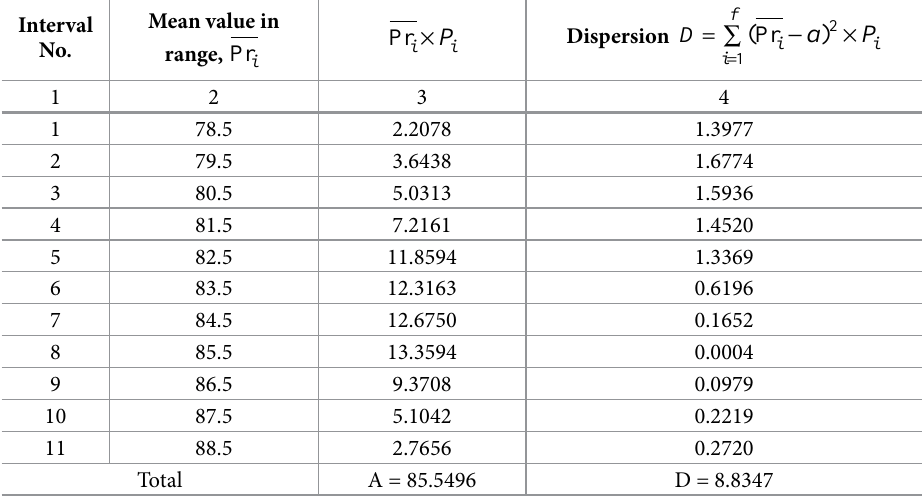
Table 5. Calculation of distribution parameters Interval No.